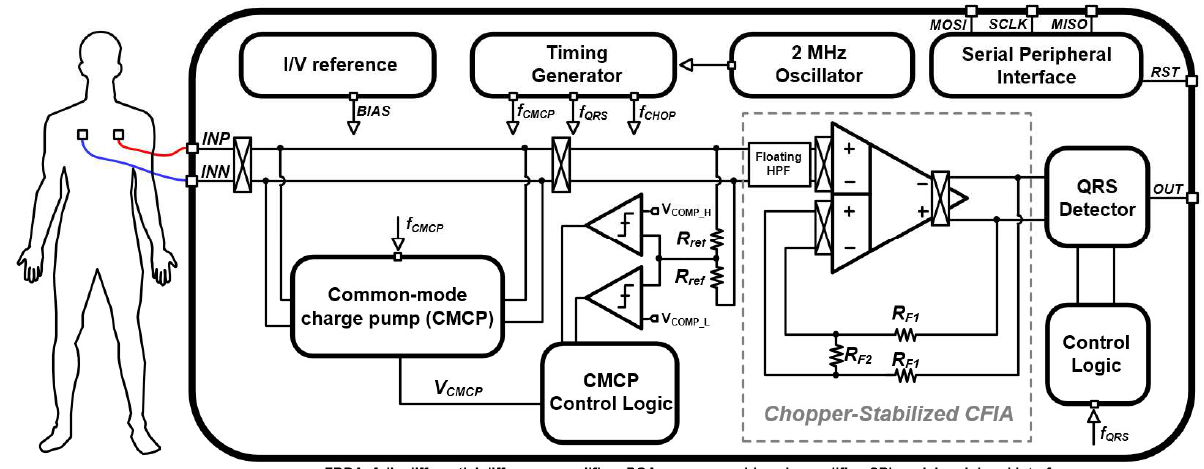
Figure 3. Block diagram of the proposed readout IC.